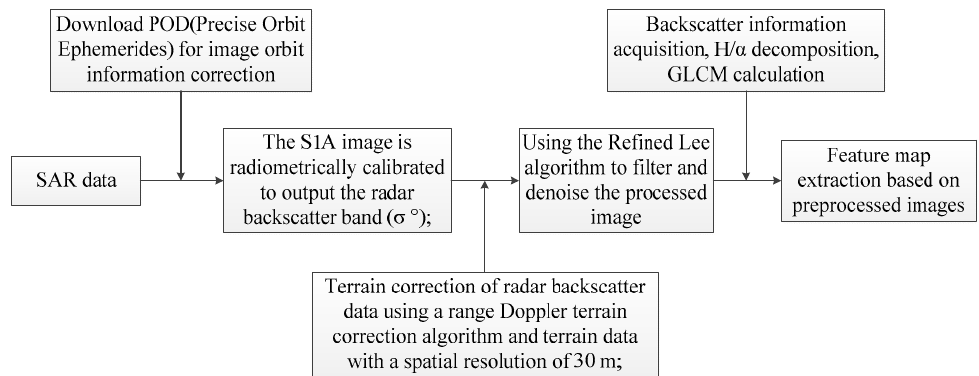
Figure 5. Data preprocessing process.